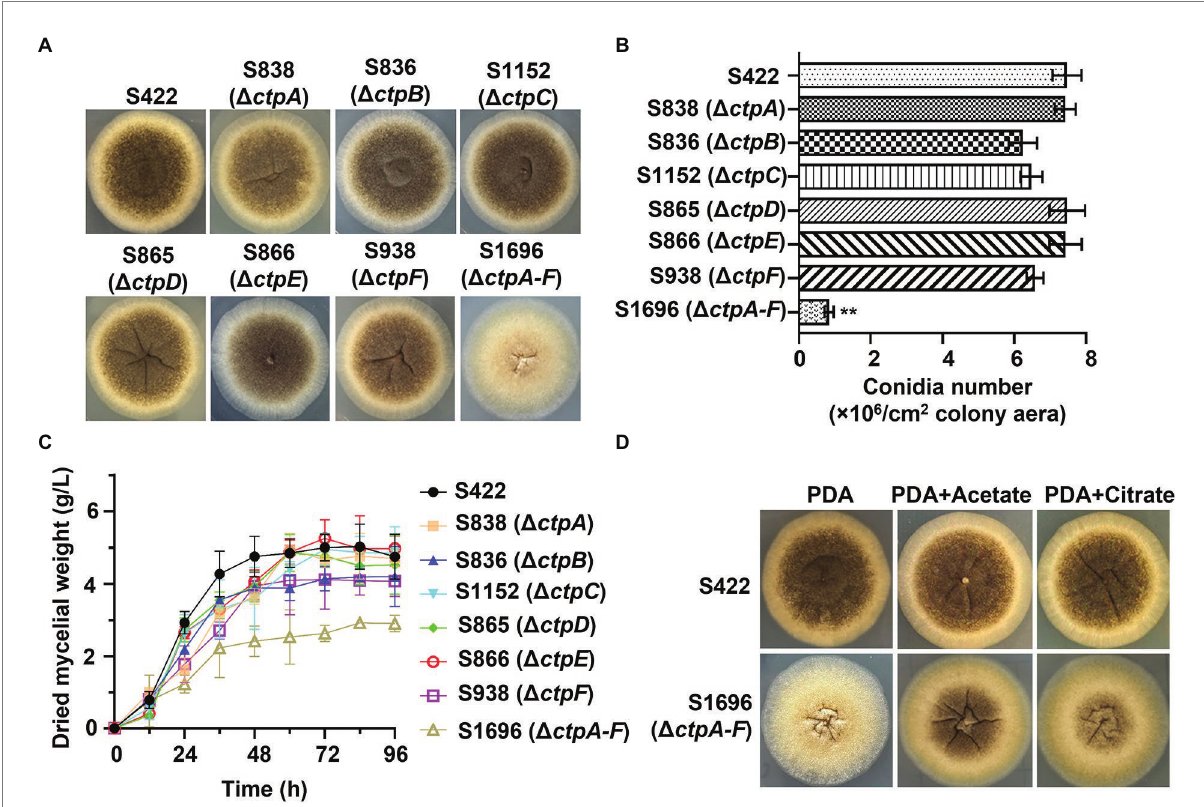
FIGURE 3 Phenotype analyses of ctp disruptions strains. (A) Morphology of A. niger S422, individual ctp disruption mutants, and Δ ctpA-F mutant grown on PDA plate at 28 ° C for 4 d. (B) The number of conidia per square centimeter of the indicated strains grown on PDA plates at 28 ° C for 4 d. (C) Growth curves of A. niger S422 and the indicated mutants in 50 ml of citric acid fermentation medium at 28 ° C, and 200 rpm. (D) Morphology of A. niger S422 and S1696 ( Δ ctpA-F ) grown on PDA plate or supplemented with 5 mM acetate or 10 mM